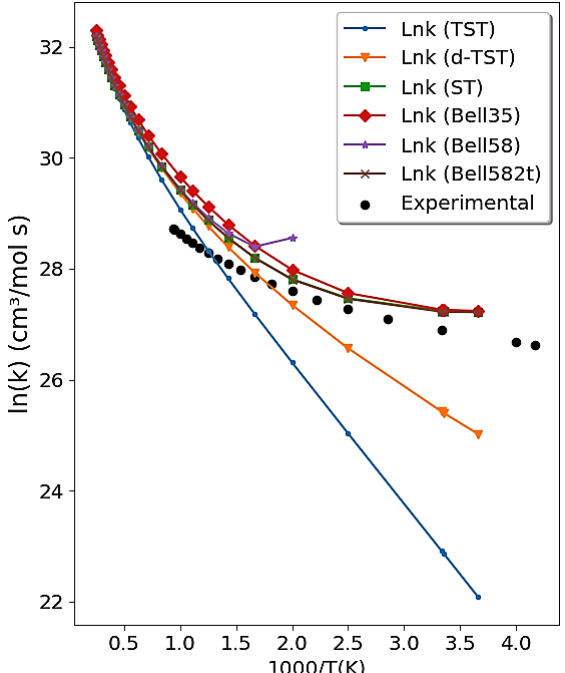
Figure 4. Arrhenius plot obtained from the Transitivity code for the OH + HCl → Cl + H 2 O reaction using TST with Bell35, Bell58, ST tunneling correction, and 𝒹 -TST. Experimental data in the literature [90] are available for comparison and shown as full dots.